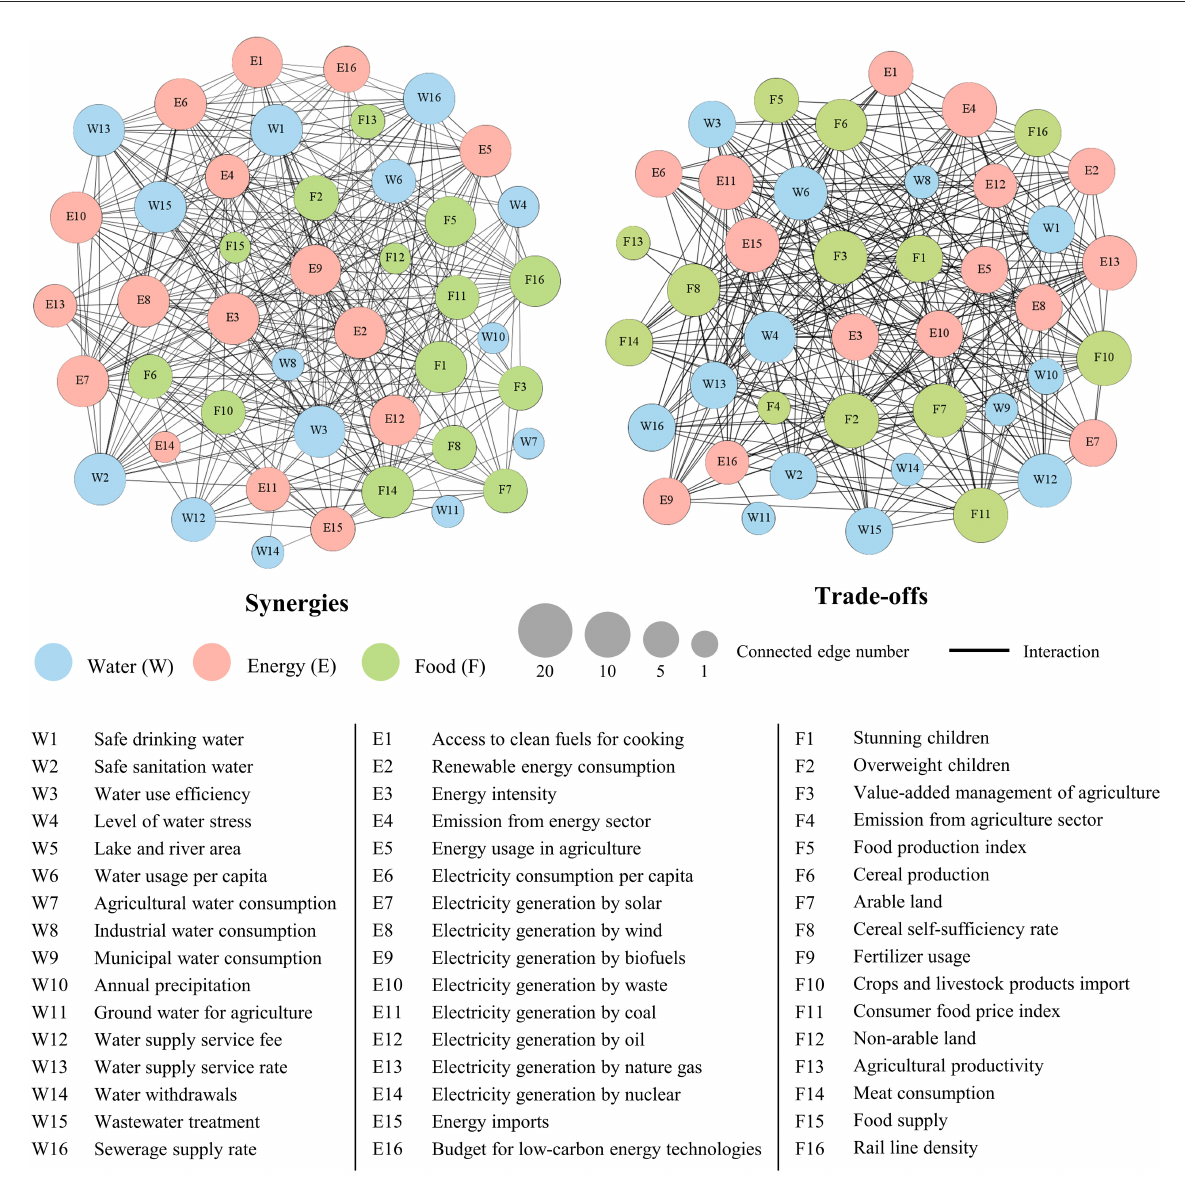
FIGURE4 Visualization of the interactions between WEF security indicators in South Korea through network